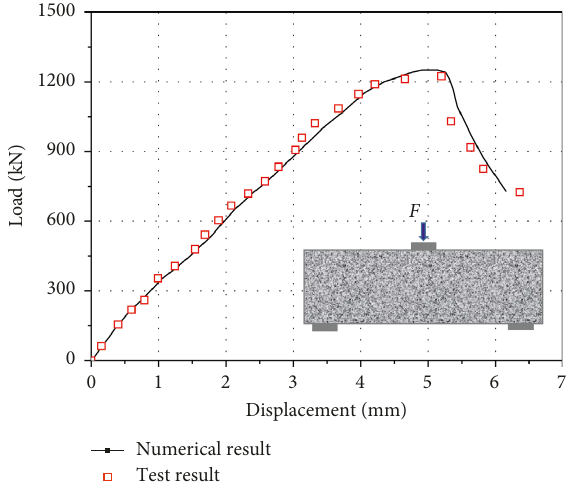
Figure 25: Load-deformation curve of the HFRC deep beam under